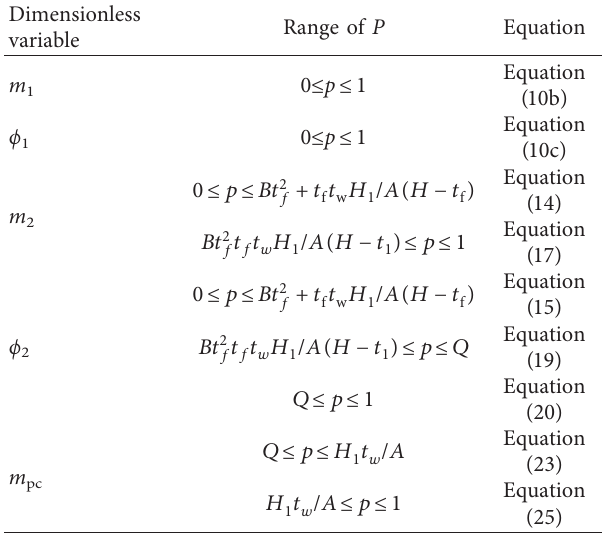
Table 2: Calculation expressions of M- Φ -P of H-section steel